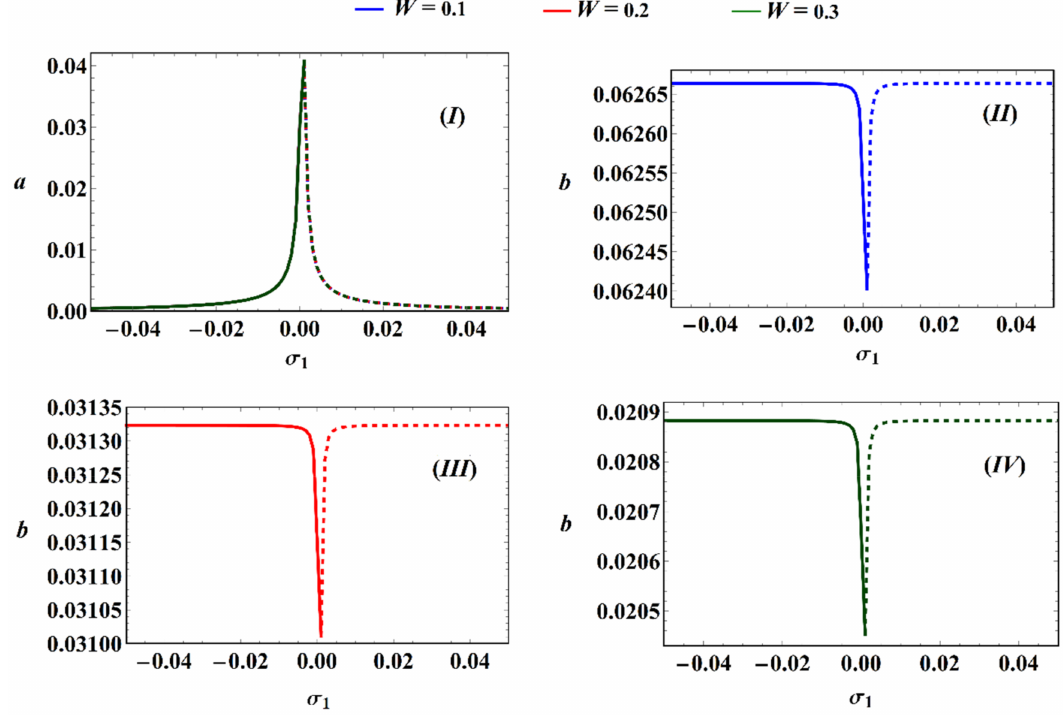
Figure 21. The frequency response at σ 2 = − 0.001, c 1 = 0.001, and c 2 = 0.011 of: a ( σ 1 ) as seen in ( I ), and b ( σ 1 ) as shown in ( II ) at W = 0.1, ( III ) at W = 0.2, and ( IV ) at W =